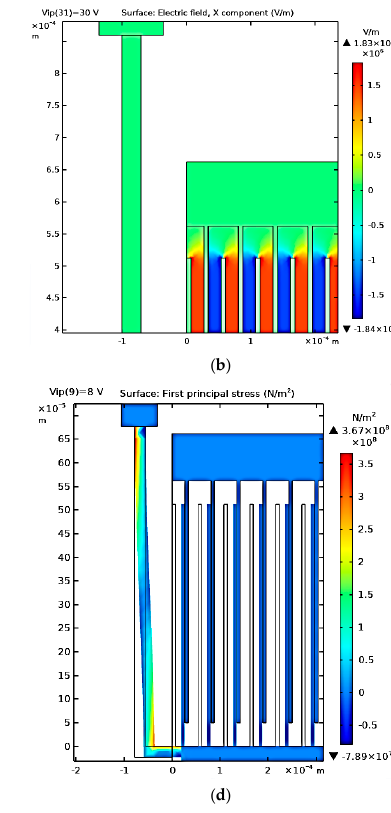
Figure 9a–e show the simulation results of the electric potential distribution, electric field distribution, the converter displacement due to the input vibration signal, the stress analysis, and the converter output power at different values of V ip . In Figure 9a, it is clear that the maximum voltage, V max , is 30 V, which numerically verifies the qualitative value in Section 4. Figure 9b displays the maximum electric field, which is 1.83 × 10 6 V/m. It is less than half of the air breakdown electric field, which is 1.5 × 10 6 V/m [46]; thus, the de- sign is safe. In Figure 9c, the maximum displacement is 19.7 µm, which agrees with the analytical value d mon. – d min. = 20 µm–0.25 µm = 19.75 µm in Section 4. Further, regarding Figure 9d, the value of the maximum stress is found to be 0.36 Gpa, which is again smaller than the fracture stress of the polysilicon. Thus, the converter design is safe against fracture. Finally, concerning Figure 9e, it is obvious that the value of the simu- lated P outmax at V max is 4.5 mW, which is double the value found for 0.35 µm CMOS tech- nology.